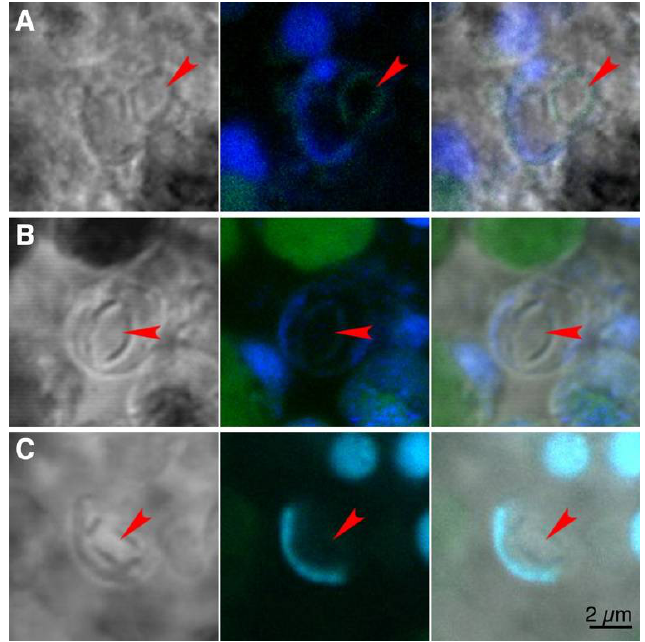
Figure 3. Fluorescence labeling (green) for potential components of organic matrix for crystal precipitation. Decalcified tissue was labeled with calcofluor white ( A ), Col-F ( B ) and a cocktail of lectins ( C ). Nuclear labeling (Propidium iodide in A and Hoechst in B and C) is blue. Left panel in each row shows an image in transmitted light, middle panel is merged fluorescence channels (maximum intensity projection through crystal cell thickness) and right panel is fluorescence channels superimposed on the transmitted light image. Arrowheads point at the site of a decalcified crystal. The scale bar is applicable to all